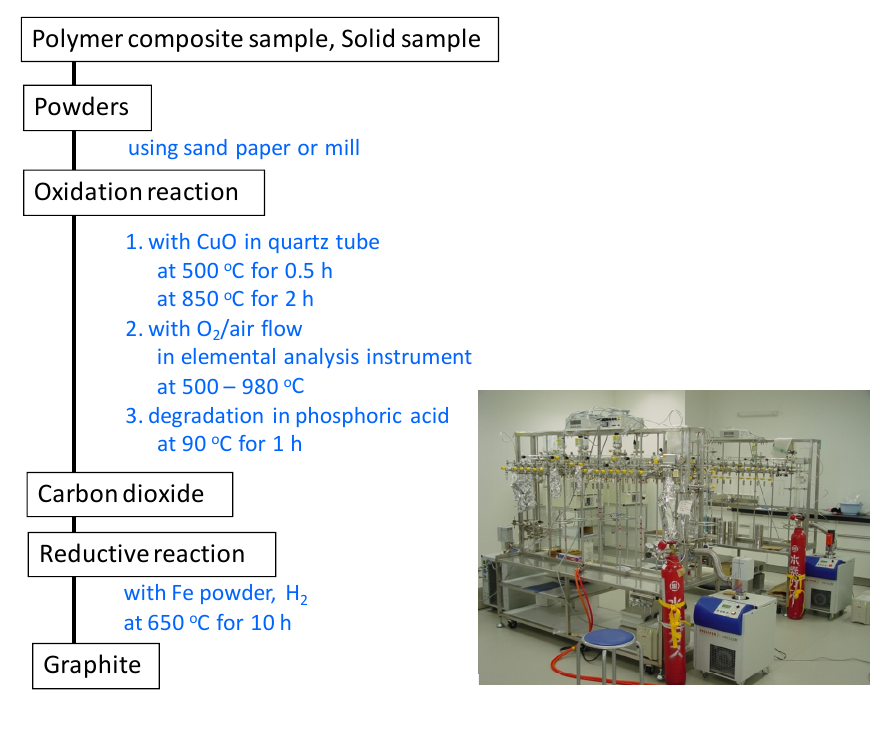
Figure 6. Sample pretreatment method for